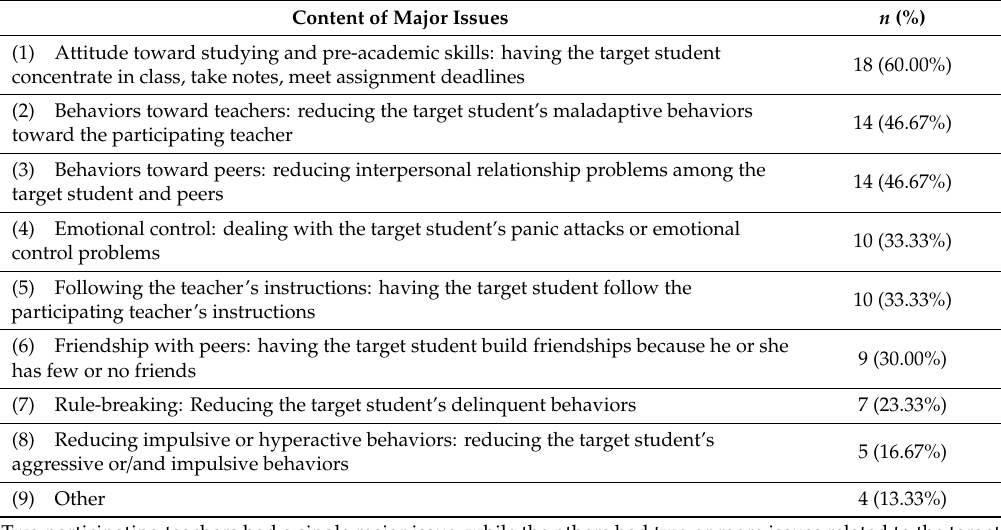
Table 1. Major issues of participating teachers ( n =